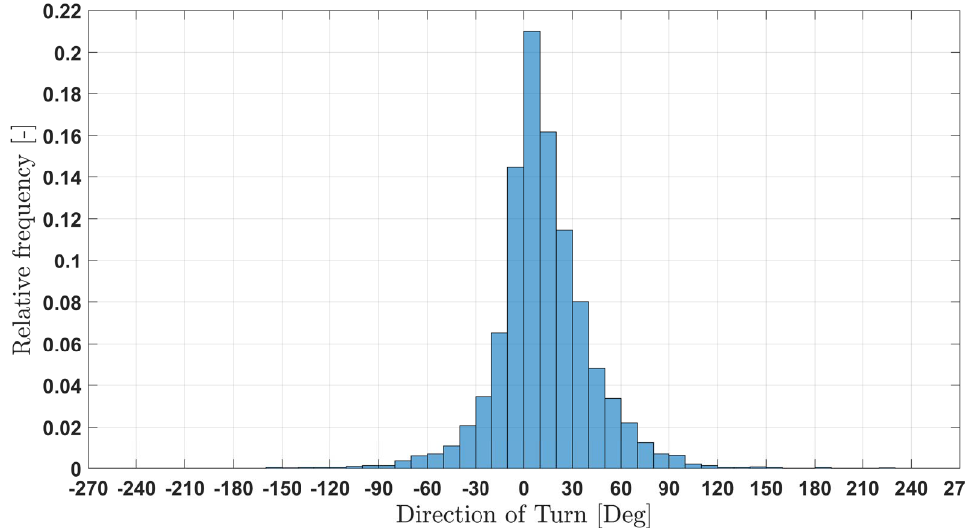
Figure 3. Relative Frequency distribution of wind direction rotation with altitude for the altitude interval of 40m to the maximum altitude of the LLJ for rotations to the left ( n = 1311) and rotations to the right ( n = 3066) at the Clausthal-Zellerfeld